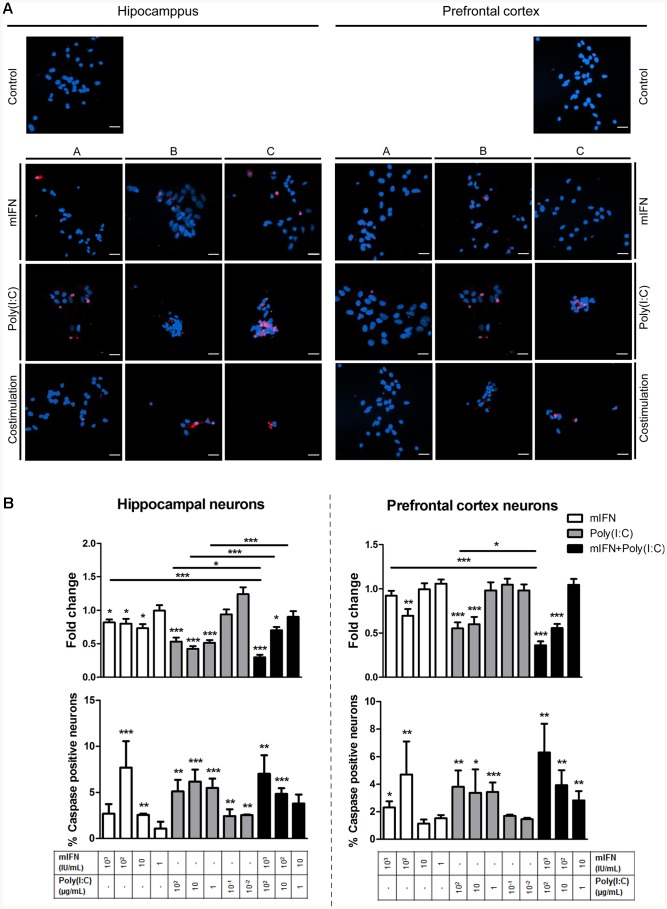
Survival and apoptosis variations in hippocampal and prefrontal cortical neurons.Cells were stimulated at 4 div during 72(A) hippocampal and prefrontal cortical neurons with different treatments stained with anti-caspase 3 (red) and Hoechst (blue). The applied treatments dosage is: in mIFN treatment (A) = 10, (B) = 100 and (C) = 1,000 IU/mL; in poly(I:C) treatment (A) = 0,1, (B) = 1, (C) = 10 µg/mL; in costimulation treatment (A) = 10 IU+1 µg/mL, (B) = 100 IU+10 µg/mL and (C) = 1,000 IU+100 µg/mL. Scale bar: 20 µm. (B) Survival and apoptosis rates, assessed as total number of nuclei/field and the percentage [%] of caspase3 positive cells at the end of the treatment measured by immunocytochemistry using anti-cleaved caspase3 counterstained with Hoechst. The data are presented as mean values (± SEM) fold changed with the control. Asterisks indicate significant results (*p<0.05; ** p<0.01; *** p<0.001) using the Student's t-test.